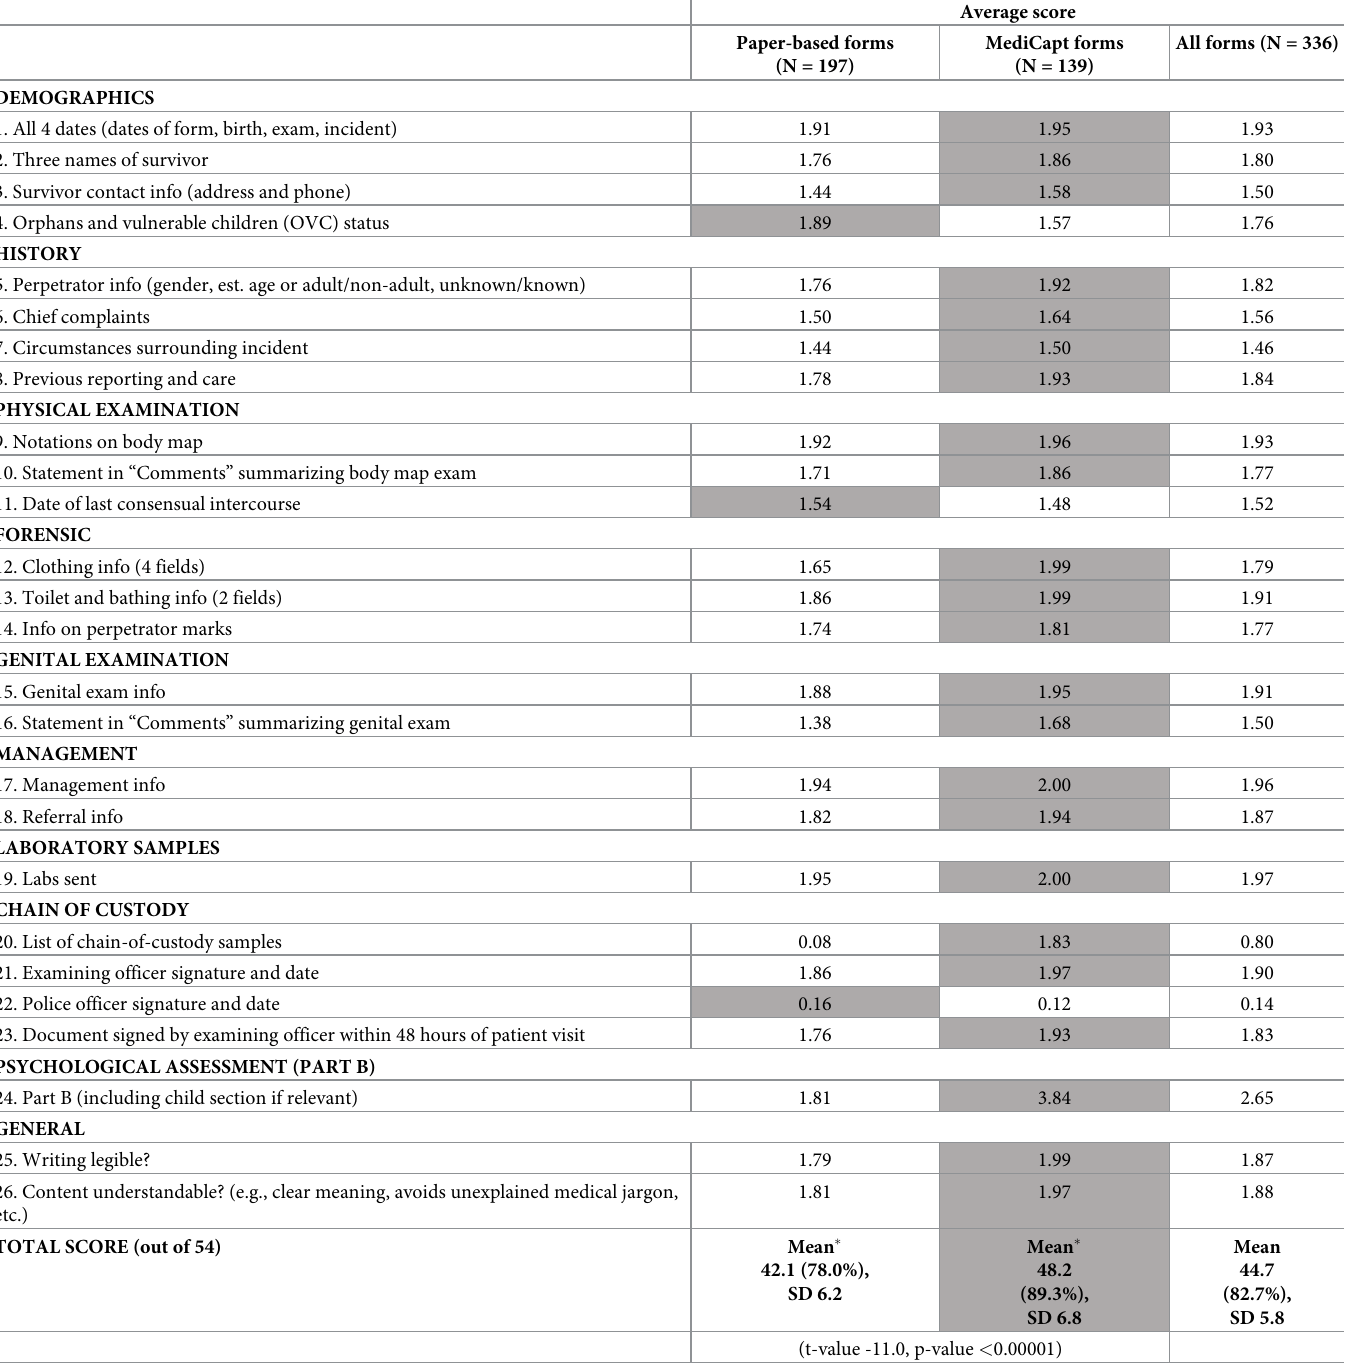
Table 1. Quality of documentation in paper-based versus MediCapt forms. Cells highlighted in gray represent the higher quality score between the two types of forms. Each item is scored from 0–2, except for Item 24, which is scored from